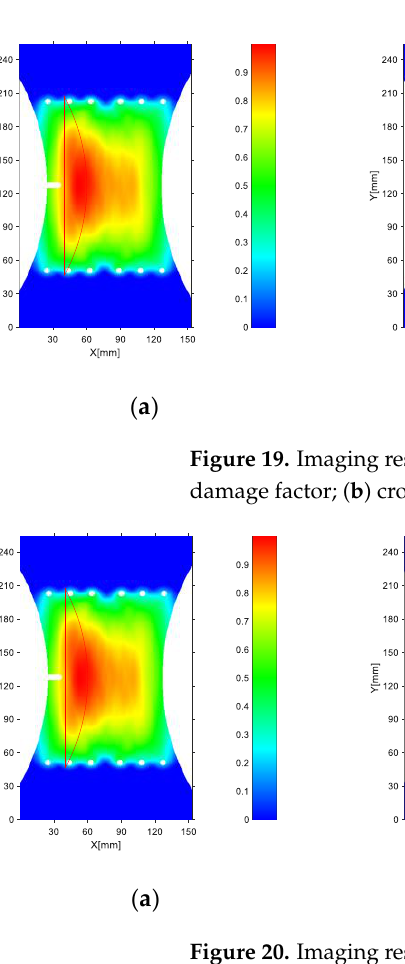
Figure 18. Damage scattering signals with different signal-to-noise ratios at 2 – 8 channels: ( a ) SNR = 6; ( b ) SNR = 3; ( c ) SNR = 0.1.